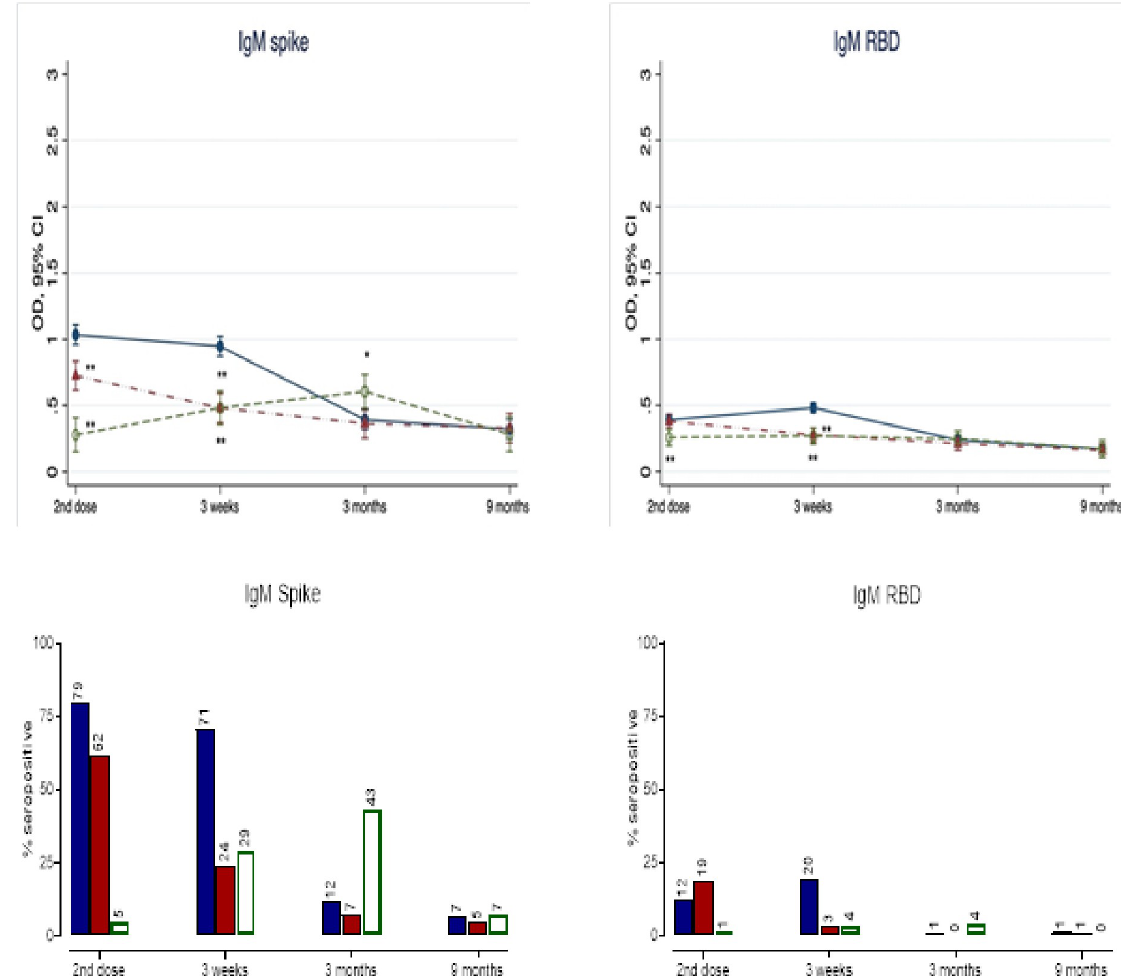
Fig 4. Mean titers and seropositivity rates for IgM to ancestral SARS-CoV-2 Spike and RBD by study visits and dosing interval groups. Upper panel: Serum IgM titers to ancestral SARS-CoV-2 Spike and RBD measured in each group at the same time points post-2 nd dose using a validated ELISA (see METHODS). Data are expressed in optical density (OD) with 95% confidence interval (CI) and fully adjusted for age, sex, education, smoking, alcohol use, body-mass index, known comorbidities (cardiovascular, neoplastic, autoimmune, renal and chronic respiratory diseases) and the number of days after 2 nd vaccine dose to subsequent blood draw. The dosing interval groups were 35- 42-days (red symbols) and > 42-days (open green symbols), who were compared to the < 35-days group (reference group, blue closed symbols). For the summary numerical data, please refer to S3 Appendix in S1 File. Interaction terms for titer levels x visit x group were all significant at p < 0.0001. Therefore, between group comparisons ( < 35-day group as reference) were conducted with p-values � < 0.05 and �� < 0.005. The red solid line represents the assay’s threshold of detection (see S1 Appendix in S1 File for numerical values). Lower Panel: The bars represent the % of participants with seropositive IgM to ancestral SARS-CoV-2 Spike and RBD within each group by visit. Seropositivity was defined by titer levels above the assay’s threshold of